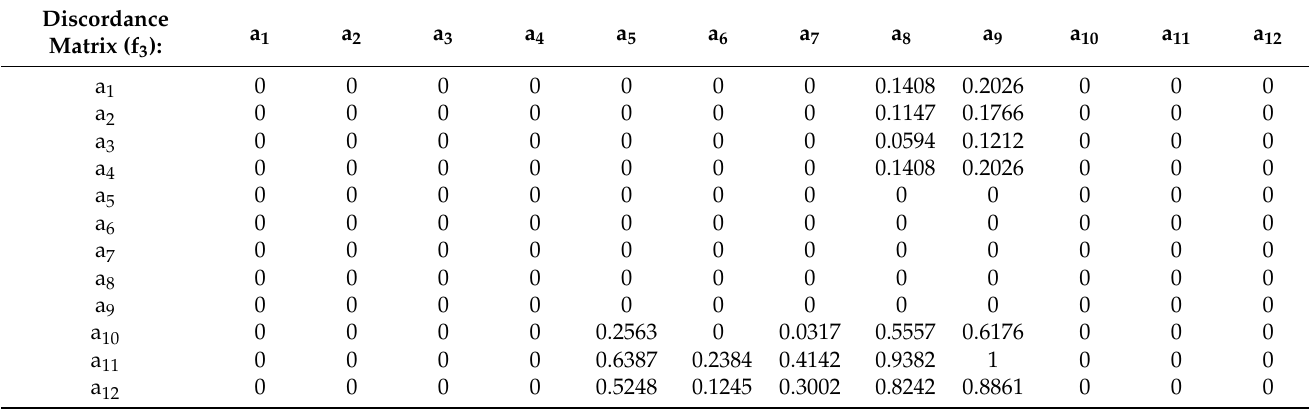
Table A3. Values of the non-compliance indicators according to the 3rd